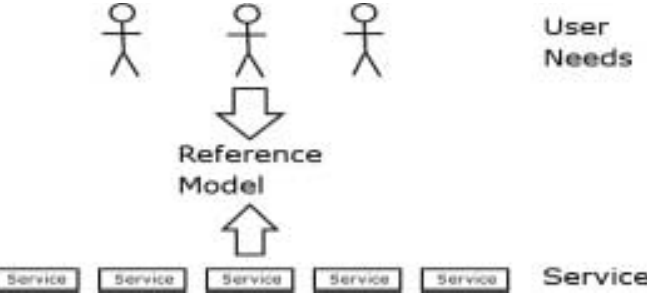
Figure 2. A reference model is a mediating representation that enables users to communicate their requirements for the services